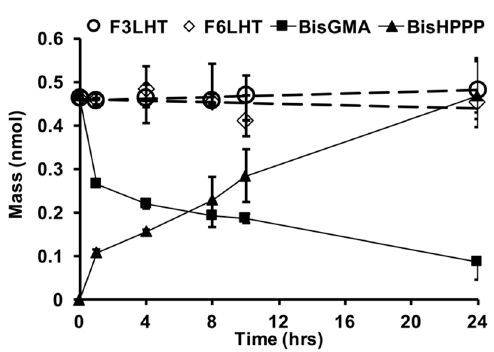
Figure 4. Hydrolytic degradation studies of two select fluorinated monomers (F 3 LHT and F 6 LHT) vs. BisGMA in the presence of 5 units/mL CE, at 37 ◦ C ( n = 3, ± SD). Table 1. Contact angle ( ◦ ) measurements are reported with ± SD for films before and after exposure to albumin (see nomenclature for chemical structures in Figure 1). * denotes significance difference ( p < 0.05) from pre-incubation value. Sample Pre-Incubation Post-Incubation with BSA Advancing Receding Hysteresis Advancing Receding